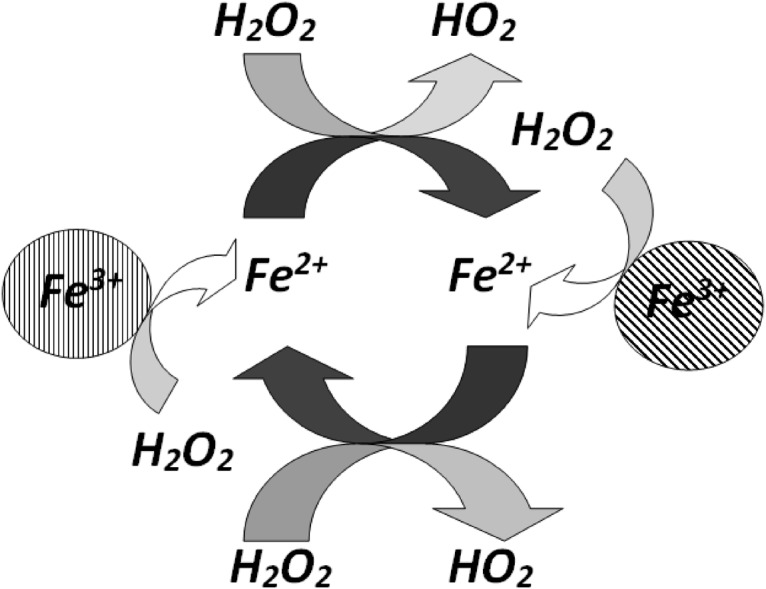
Mechanism Description.